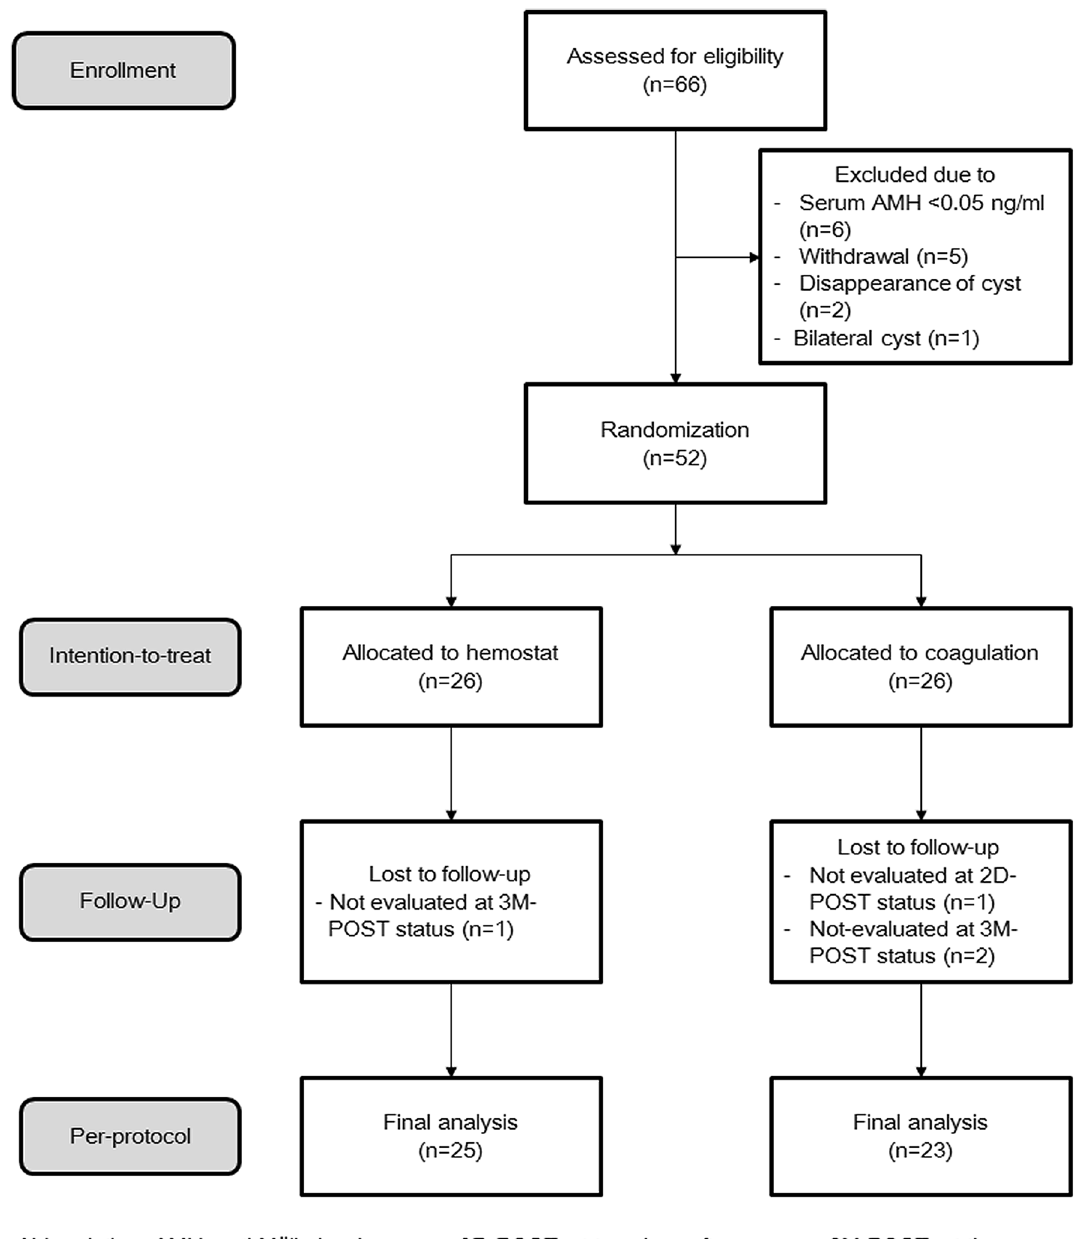
Figure 1. Flowchart based on Consolidated Standards of Reporting